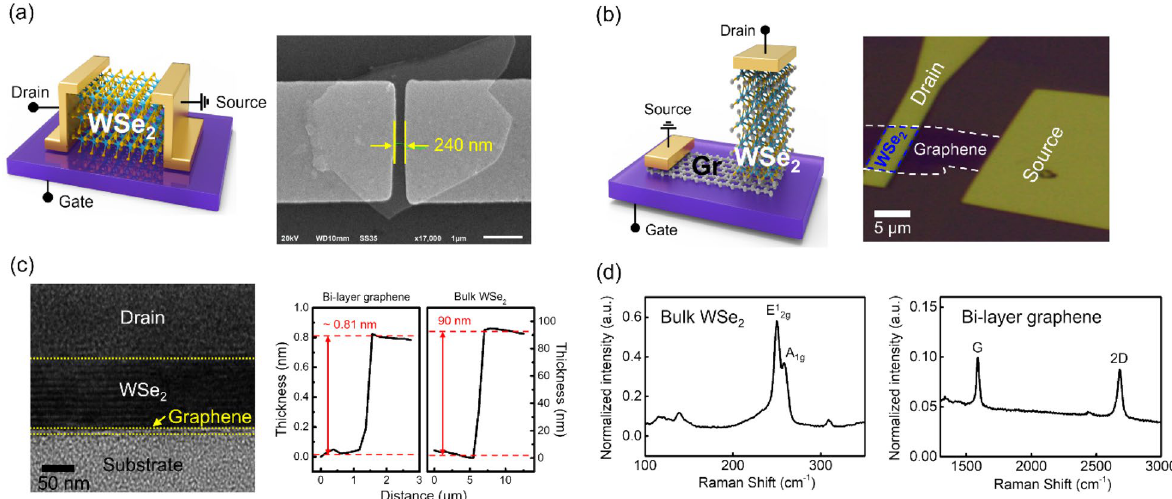
Fig. 1 Device structures and sample characterization. a Left panel: schematic of the lateral WSe 2 FET. Right panel: SEM image of the lateral WSe 2 FET, with the channel length indicated. b Left panel: schematic of the vertical WSe 2 FET employing a WSe 2 /graphene heterostructure. Right panel: OM image of the vertical WSe 2 FET. c Corresponding HR-TEM image and AFM data indicating the thickness of the WSe 2 /graphene heterostructure (the thickness of the WSe 2 used in the lateral FET is also same as 90 nm). The stacked structure consists of bi-layer graphene, bulk WSe 2 , and an Au electrode as the drain. d Raman spectra of mechanically exfoliated WSe 2 and bi-layer graphene used for in the fabrication of